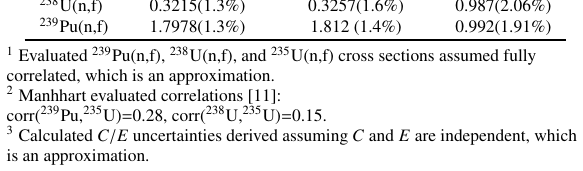
Table 2: Fission SI in 252 Cf(sf) neutron spectrum.